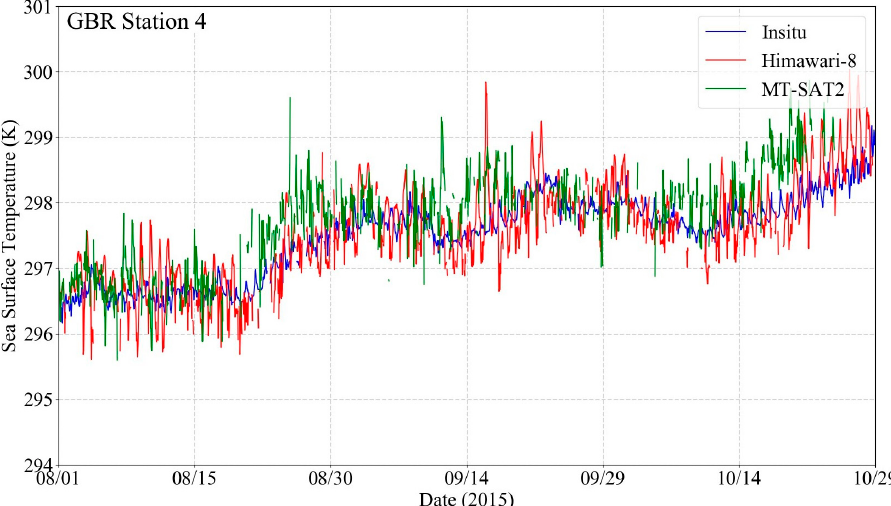
Figure 4. Time series of temperature measurements at the depth (1.9 m) of the corals GBR-4 station at 18.49°S, 146.87°E (blue), and the satellite-derived SST from Himawari-8 (red) and MTSAT-2 (green).